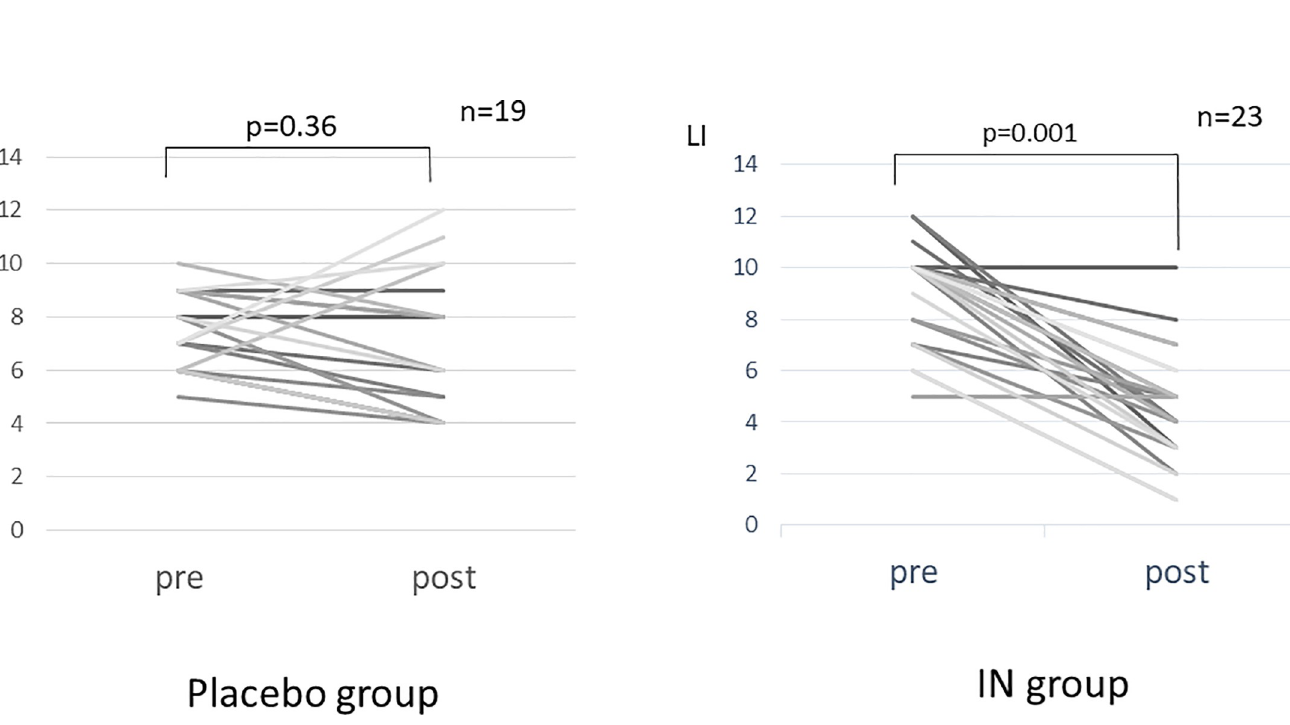
Fig 2. Individual changes in the Lichtiger index before and after the intervention. IN: indigo naturalis; LI: Lichtiger index.